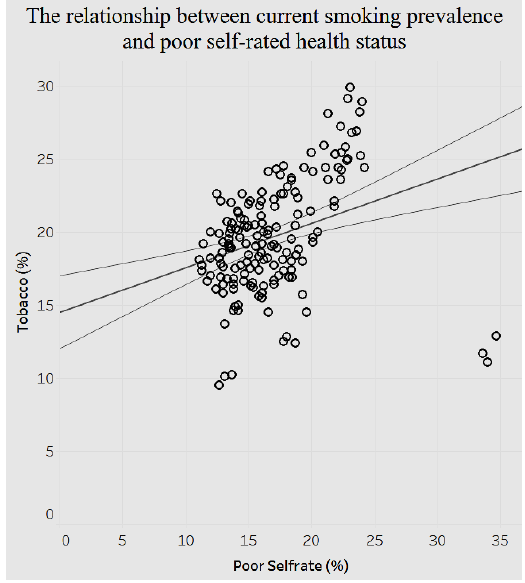
Figure 19. Smoking by self-rated health status.